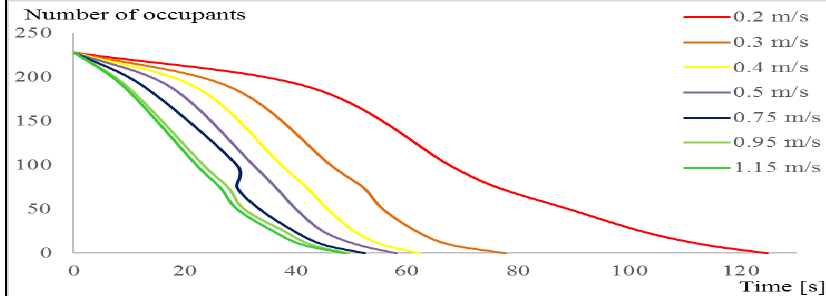
Figure 12 – Simulation results for the fastest times of the second case of the second scenario